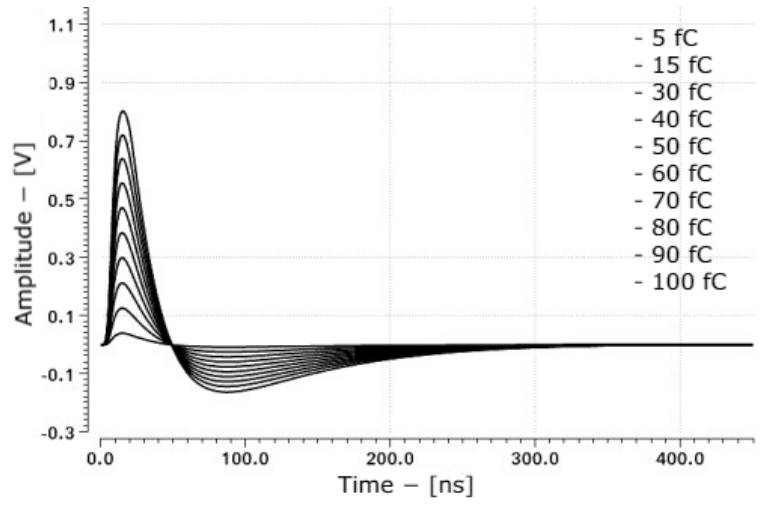
Figure 11. Analog channel output signal vs. input charge (5 fC–100